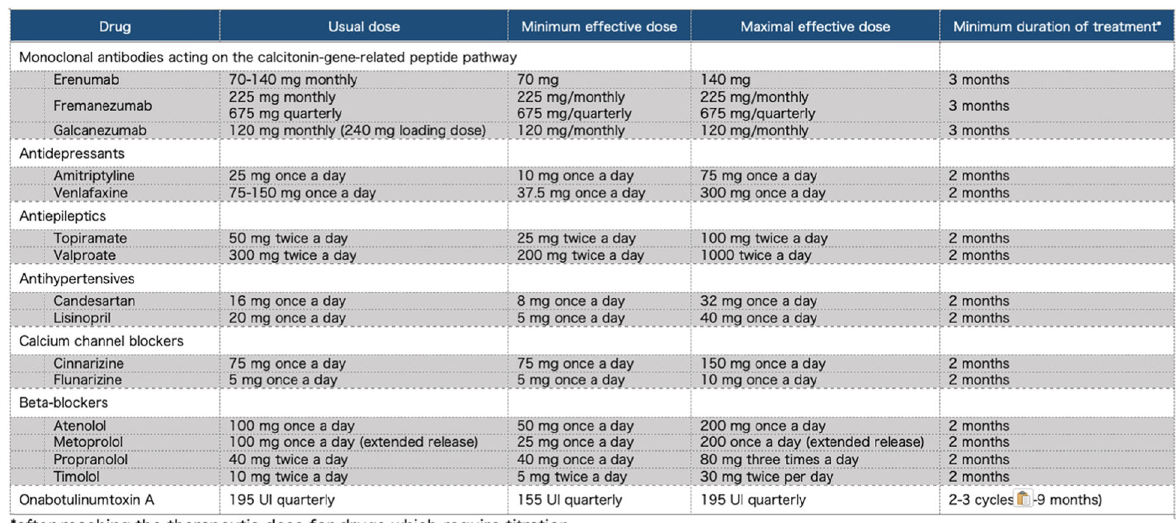
Table 4 Suggested doses and duration for assessment of lack of efficacy